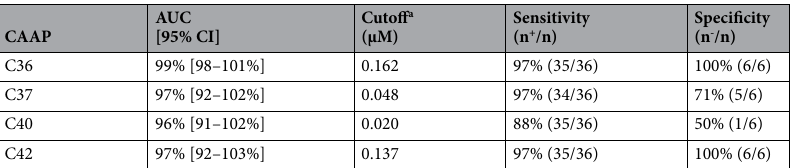
Table 5. Accuracy of selected CAAPs for their potential to discriminate sepsis patients from healthy individuals. The data set used was the same as in Fig. 2. a Cutoffs are derived from Kolmogorov–Smirnov statistics. AUC: area under the receiver operating characteristics curve; CI: confidence interval; n + : measurements with positive test results; n - : measurements with negative test results; n: all measured values.